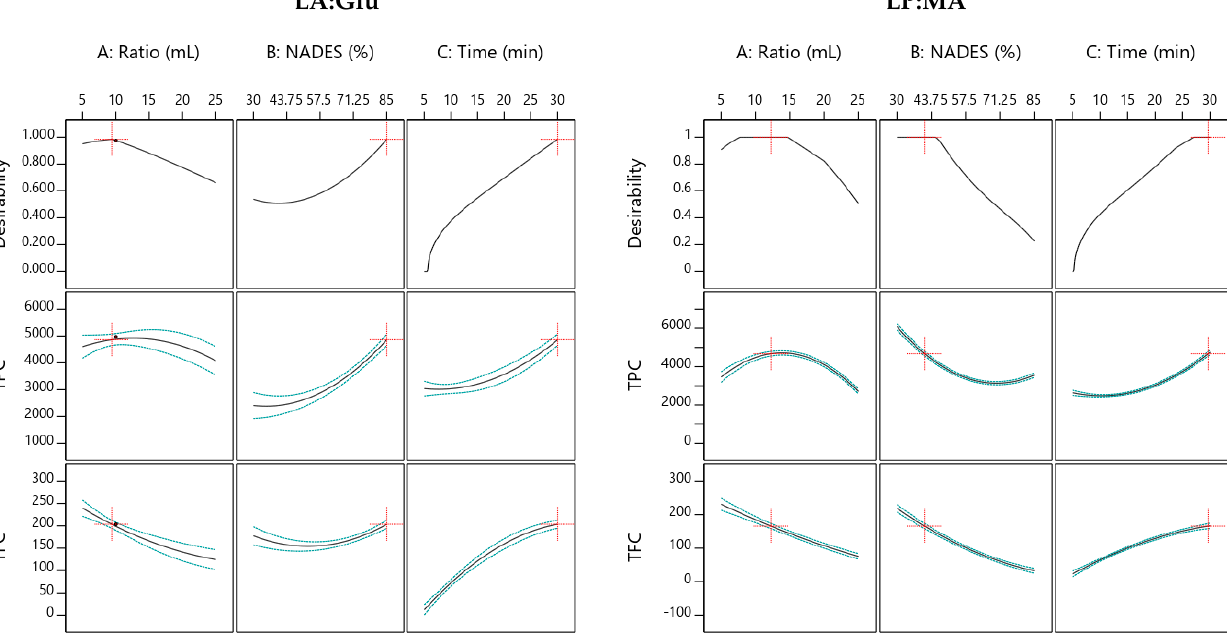
Figure 5. Optimal conditions for the extraction of TPC and TFC simultaneously using LA:Glu and LP:MA as solvent. A: ratio (mL per 1 g of peel); B: NADES in water (%, v / v ); C: time extraction(min)